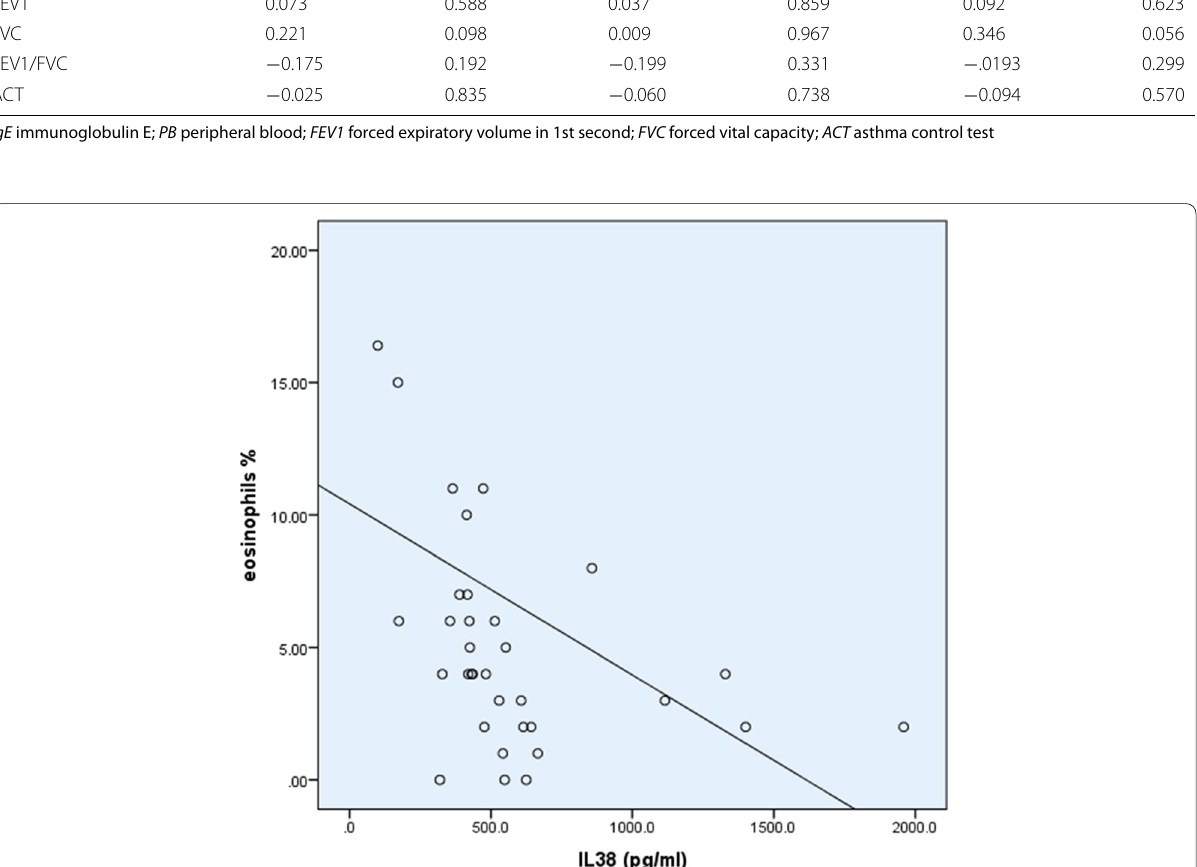
Fig. 3 Correlation between relative blood eosinophilic counts and IL-38 serum levels in atopic asthmatic